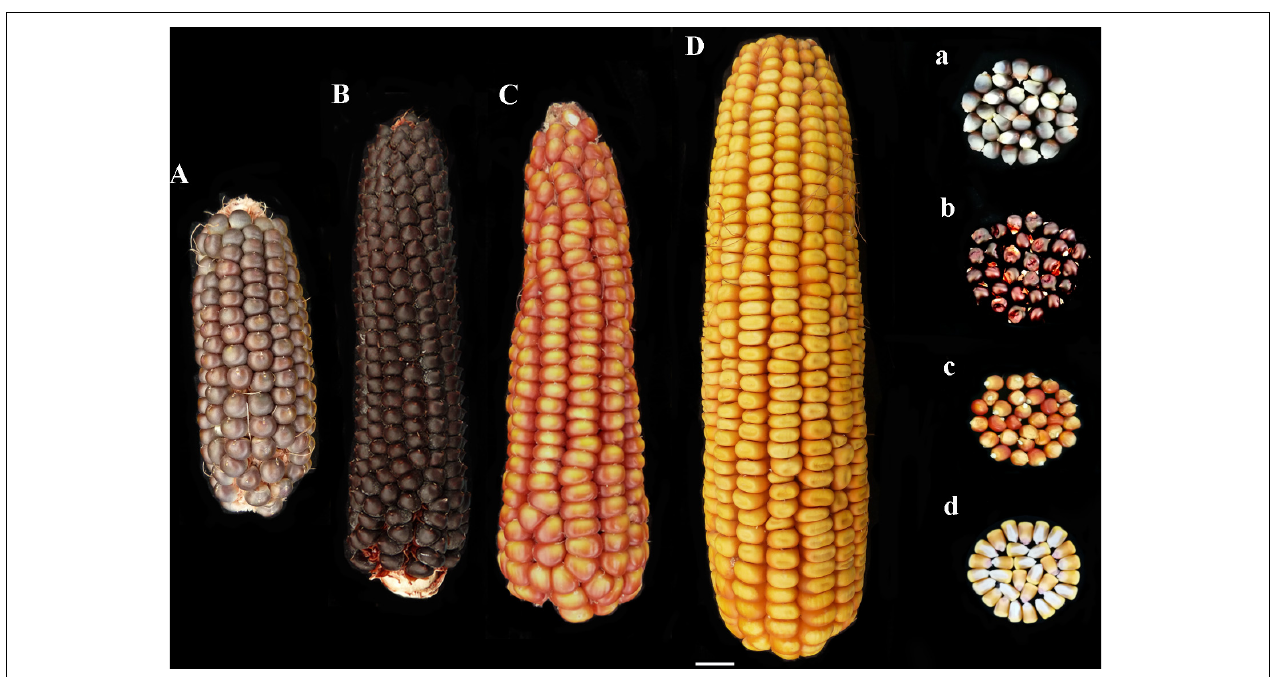
FIGURE 1 | Phenotype of ears and kernels of “Purple B73” (Aa) , “Rostrato Rosso” (Bb) , “Nostrano della Val di Non” (Cc) , and control (Dd)